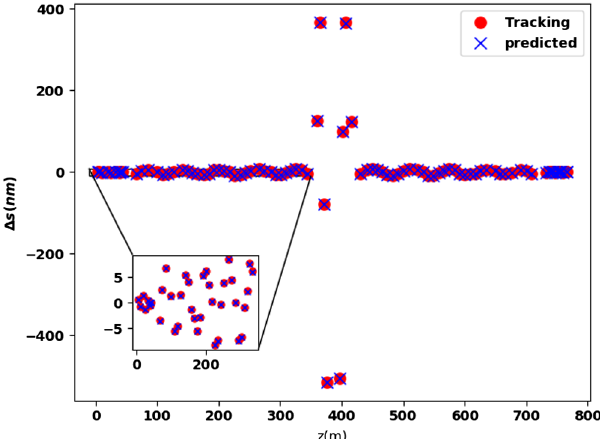
FIG. 4. Mean longitudinal displacement computed from par- ticle tracking in TAO for individual dipole errors (red dots) and predicted values (blue x ’ s) assuming a relative error R The eight largest displacements correspond to dipoles inside the arc bypass.